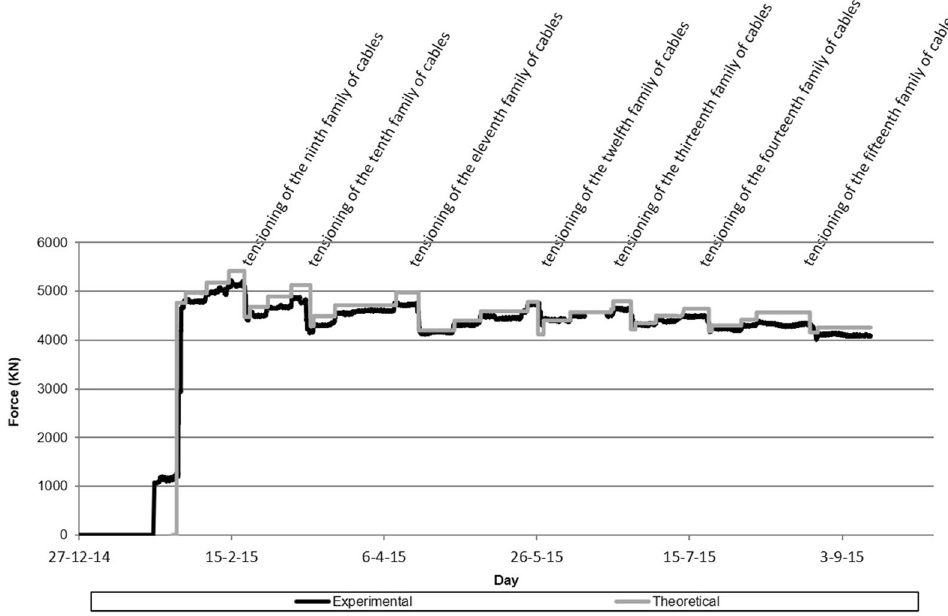
Figure 4. Evolution of the stress experienced by the eighth retaining cables